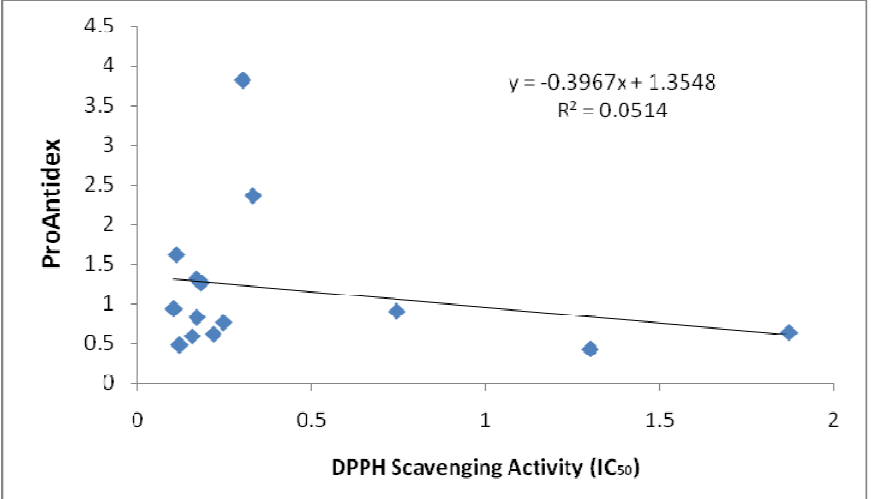
Figure 2. Correlation between ProAntidex and DPPH scavenging activity of ethanolic extracts that we used in this